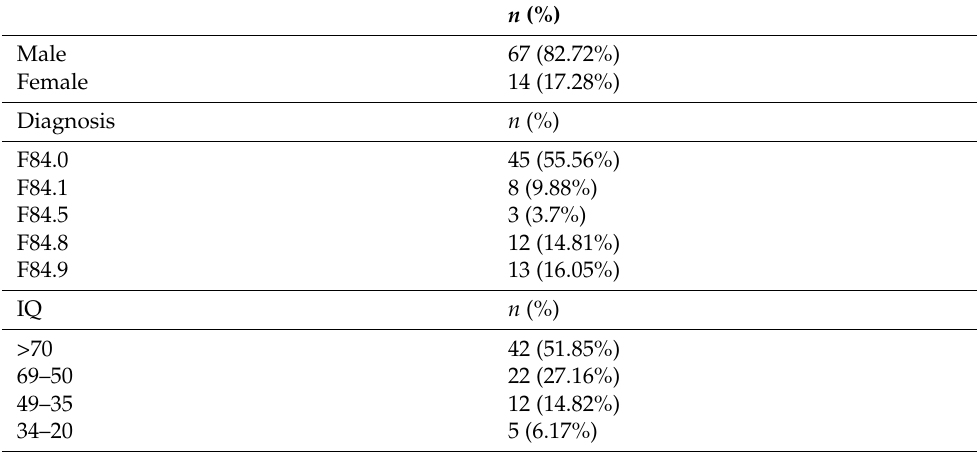
Table 1. Demographic and clinical characteristics of the sample ( n =